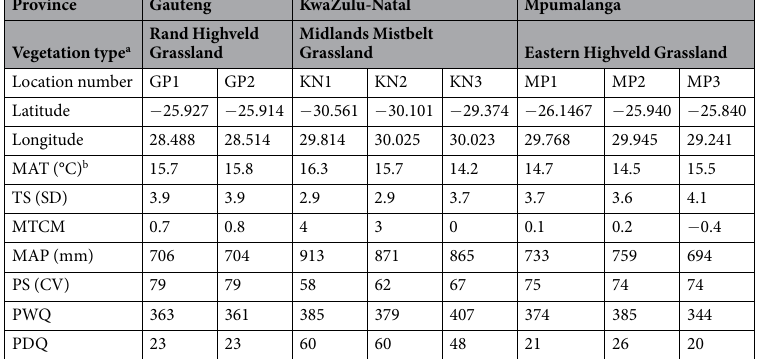
Table 1. Geographic location, mean annual temperature (MAT), temperature seasonality (TS, standard deviation), minimum temperature of coldest month (MTCM), mean annual precipitation (MAP), precipitation seasonality (PS, coefficient of variation), precipitation of wettest quarter (PWQ), precipitation driest quarter (PDQ) and vegetation type of the study sites. a Vegetation data was obtained from ref. 79. b Climatic data was obtained from ref.